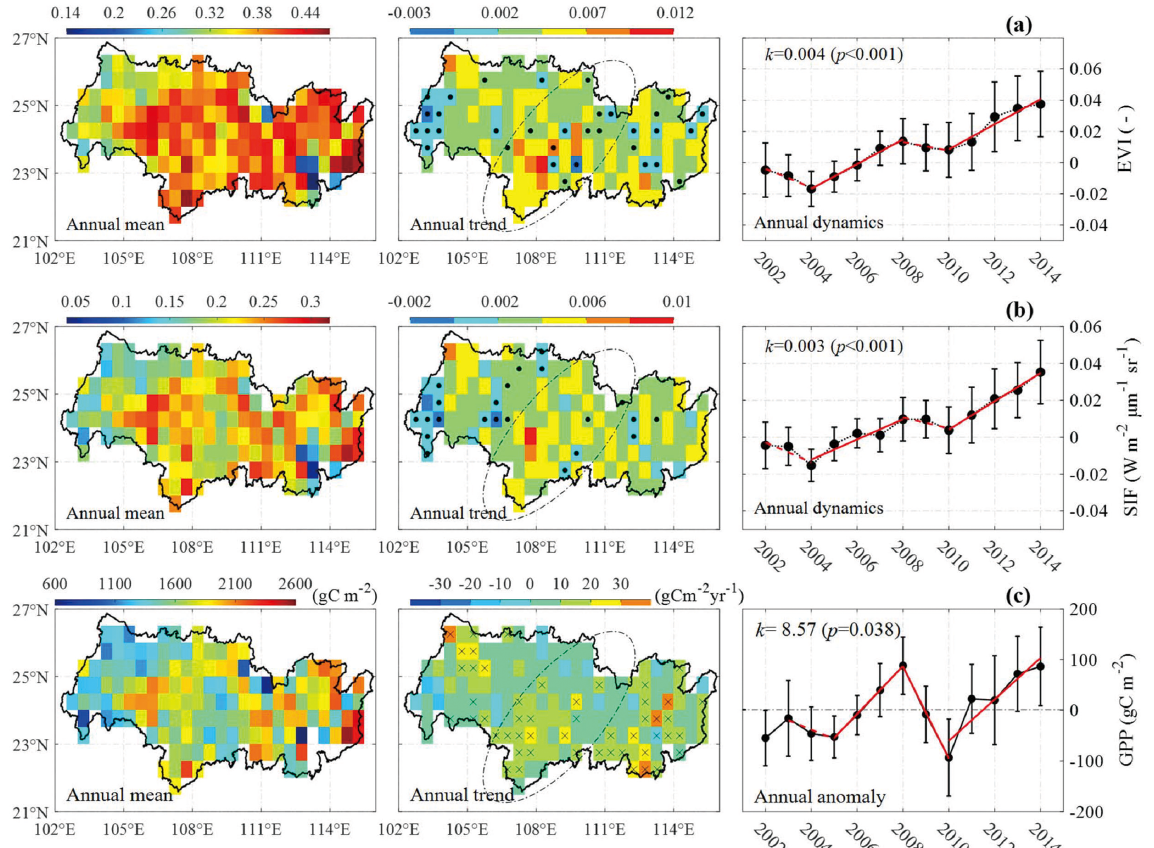
Figure 4. Spatial distribution of mean annual values, linear trends, and temporal dynamics for (a) enhanced vegetation index (EVI), (b) solar- induced chlorophyll fluorescence (SIF), and (c) gross primary production (GPP) during hydrologic years 2002–2014. Red lines show the annual trends in different periods. Dashed red lines show statistically insignificant trends ( p > 0 . 05). The ellipse marks the areas where croplands dominate. Black dots indicate p > 0 . 05 for the trend in the relevant pixels, and black crosses indicate p < 0 . 05 for the trend in the relevant pixels.